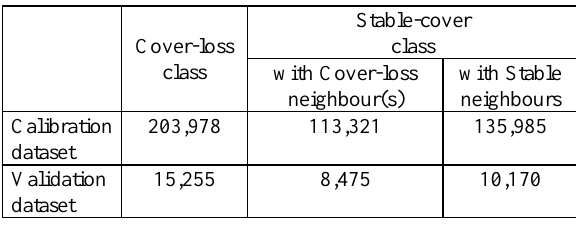
Table 1 . Sample dataset sizes used for the NN